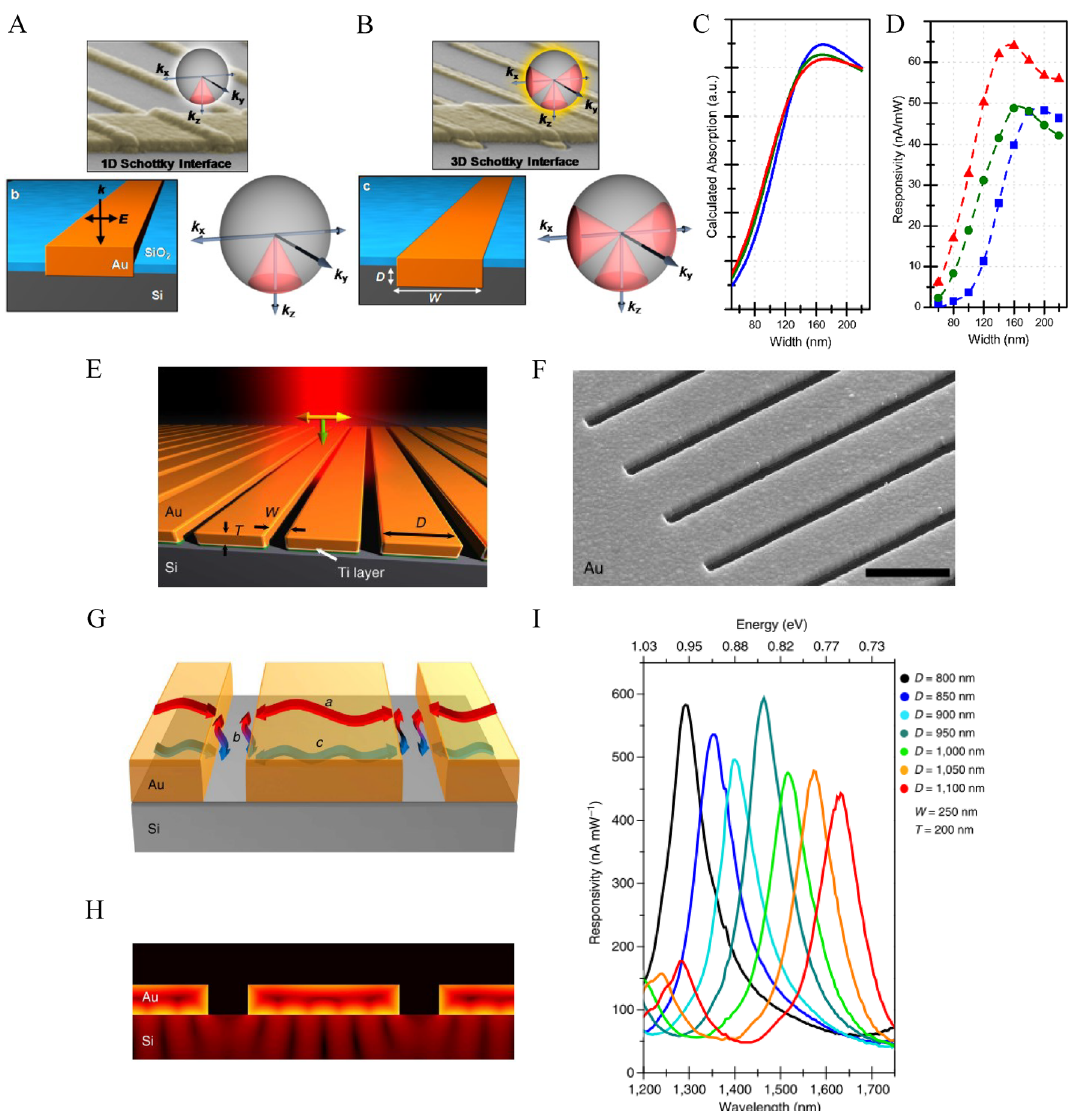
Figure 7: SEM images and schematic representations of (A) the planar and (B) the embedded active optical antenna-based devices. (C) Simulated absorption and (D) measured photoresponsivity of the embedded active optical antenna-based devices at a wavelength of 1550nmfortheembeddingdepthof5nm(blueline),15nm(greenline),and25nm(redline).Thethicknessofgoldnanowiresis35nmforallof the embedded active optical antenna-based devices [42]. Copyright 2013, American Chemical Society. (E) Schematic representation and (F) SEM image of the active optical antenna-based device featuring gold nanograting structure. The scale bar in the SEM image is 1 μ m. (G)Propagationof surfaceplasmonongoldnanogratingstructures.a,b,andc indicatedin(G)is thesurfaceplasmonpolaritons oscillatingat the top surface,sidewall,andbottom surfaceof nanograting,respectively.(H) Simulated absorptiondistributionsof Au nanograting onthe Si substrate at a wavelength of 1460 nm. (I) Spectral photoresponsivity of the active optical antenna-based device featuring gold nanograting structure with the increment of the inter-slit distance ( D ) of nanograting from 800 to 1100 nm [45]. Copyright 2013, Springer